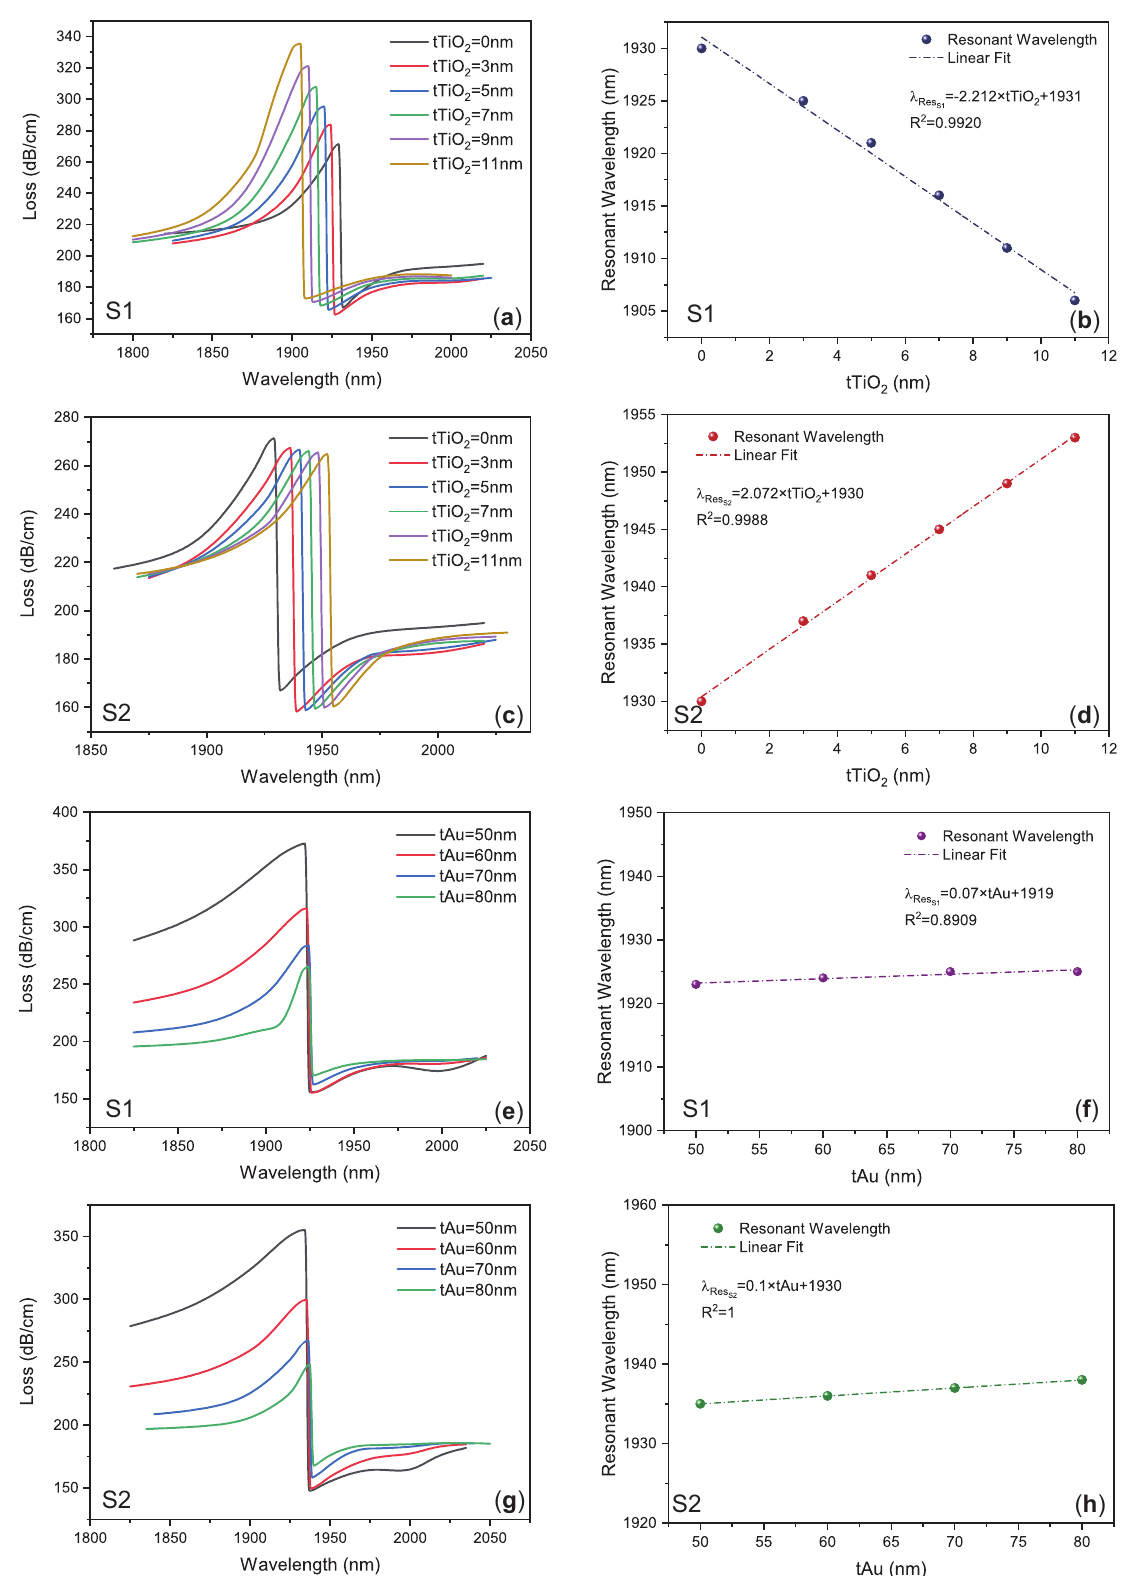
Figure 6. ( a – d ) The variation of loss spectrum and the corresponding peak wavelength with respect to the change of the thickness of TiO 2 film in S1 and S2, respectively ( Λ = 2600 nm, t SiO ( e – h ) The variation of loss spectrum and the corresponding peak wavelength with respect to the change of the thickness of gold film in S1 and S2, respectively ( Λ = 2600 nm, t SiO